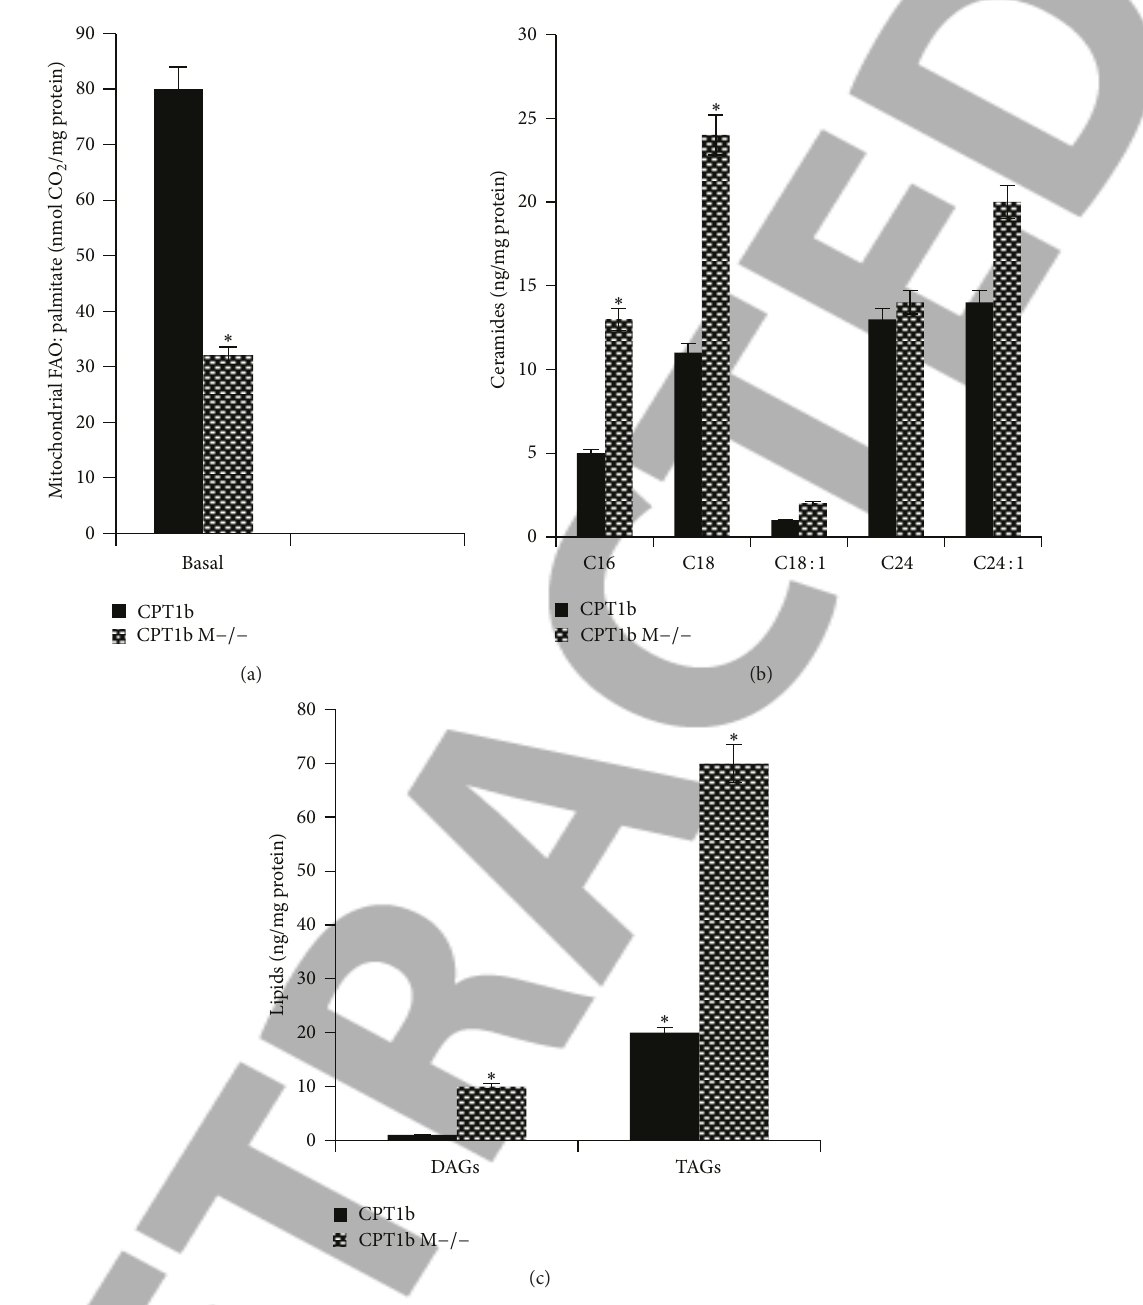
Figure 2: (a) Basal mitochondrial FAO was reduced in the skeletal muscle of knockout mice, compared with wild type ( ∗ 𝑃 < 0.05 ). (b) Ceramides were accumulated in skeletal muscles of knockout mice, especially for C16 and C18 ( ∗ 𝑃 < 0.05 ) but not for C18:1 or C24 or C24:1. (c) DAGs and TAGs were accumulated in skeletal muscles of knockout mice ( ∗ 𝑃 < 0.05 ). 𝑛 = 20 for each group.